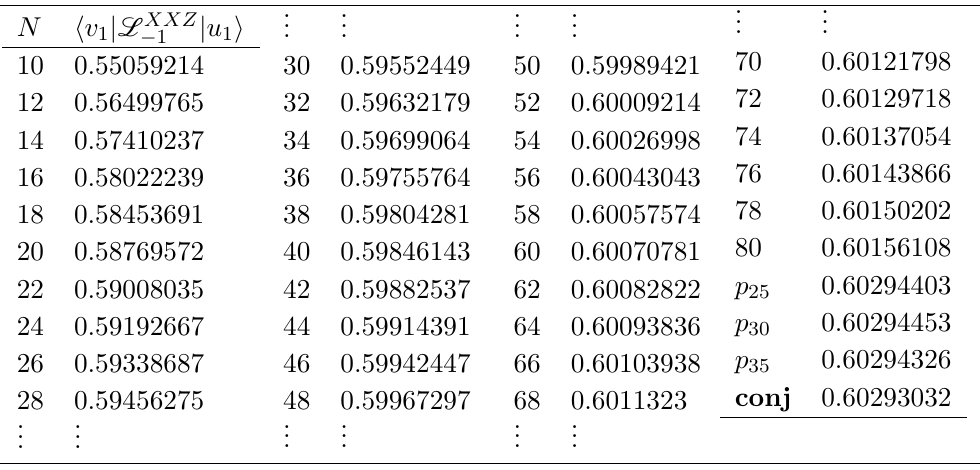
Matrix element ( L XXZ [ N ]) v , where the scaling states j u 1 i and j v 1 i follow the (cid:0) 1 1 u 1 patterns of Bethe integers shown in (5.4) and (5.5). The numerical values are given for the case of S z = 1 ; e = 0 ; x = (cid:25); (cid:30) = 1 = 10. For comparison, the matrix elements ( L (cid:0) 1 [ N ]) v were given in 1 u 1 table 1. The same conventions regarding extrapolation are used in this